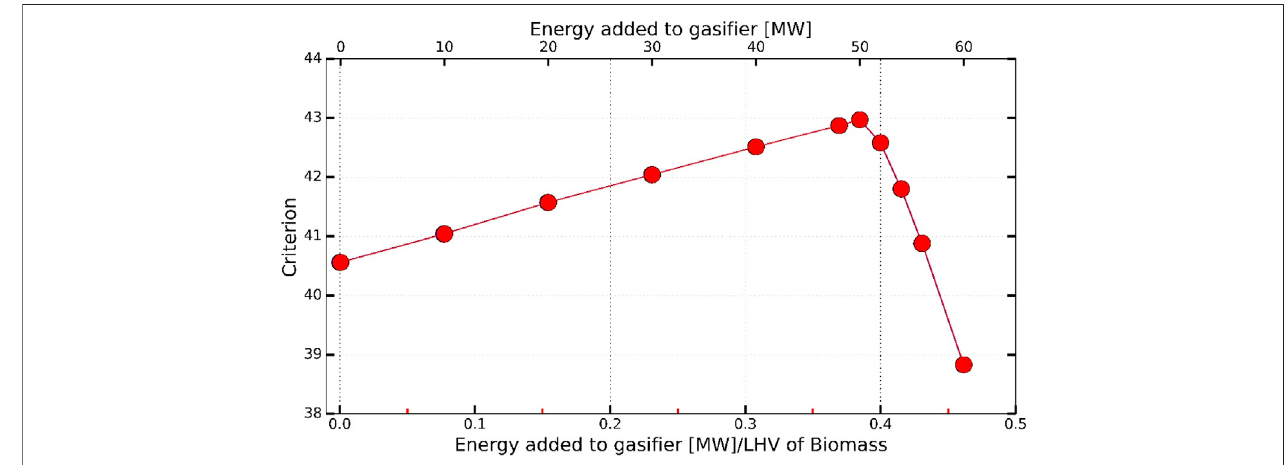
FIGURE 8 | Cheap renewable hydrogen import scenario.